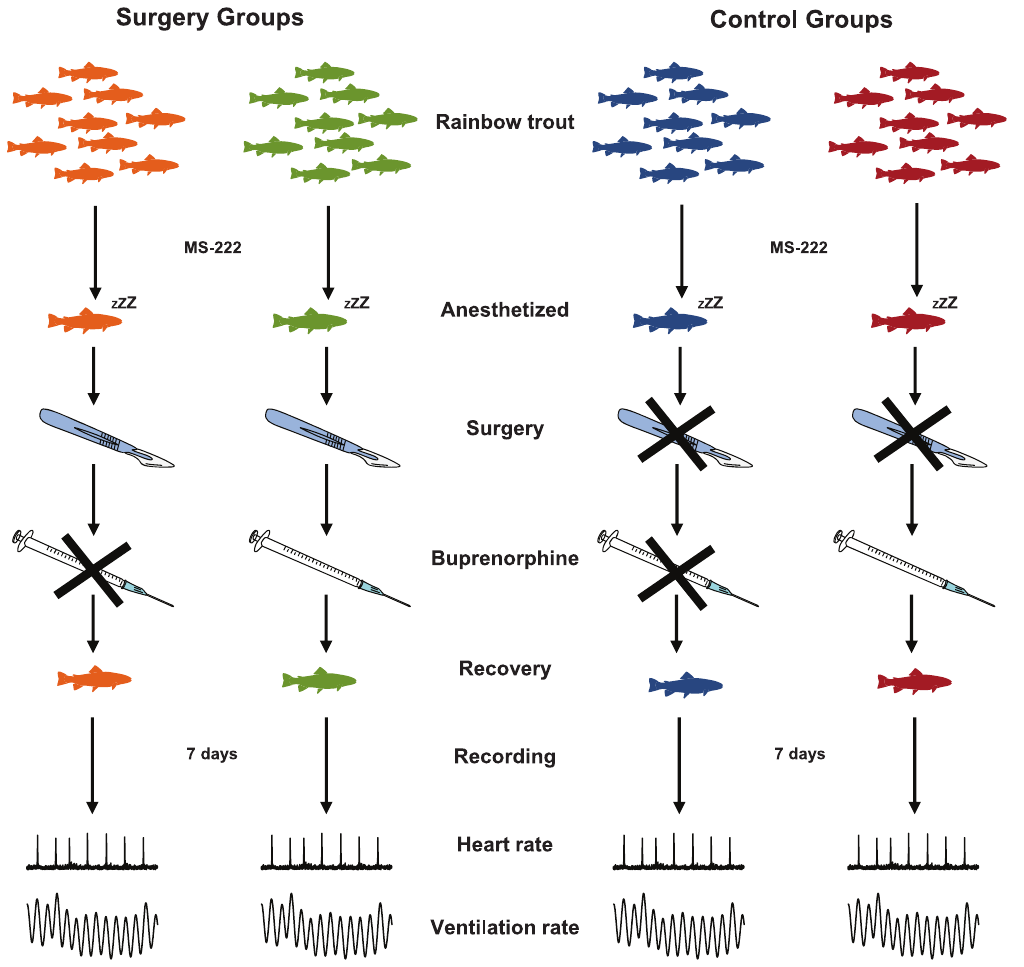
Figure 1. Rainbow trout ( Oncorhynchus mykiss ) divided into two experimental groups subjected to four different treatments. The ‘‘surgery groups’’ consist of fish in which an abdominal incision is made (indicated with a scalpel) while the ‘‘control groups’’ were treated identically with the only exception that no abdominal incision was made. Fish from each of the surgery and control groups were given a postoperative intramuscular injection of the opioid buprenorphine (0.05 mg kg 2 1 ) indicated with a syringe. After recovering from anaesthesia, ventilation and heart rates were recorded for 7 days.